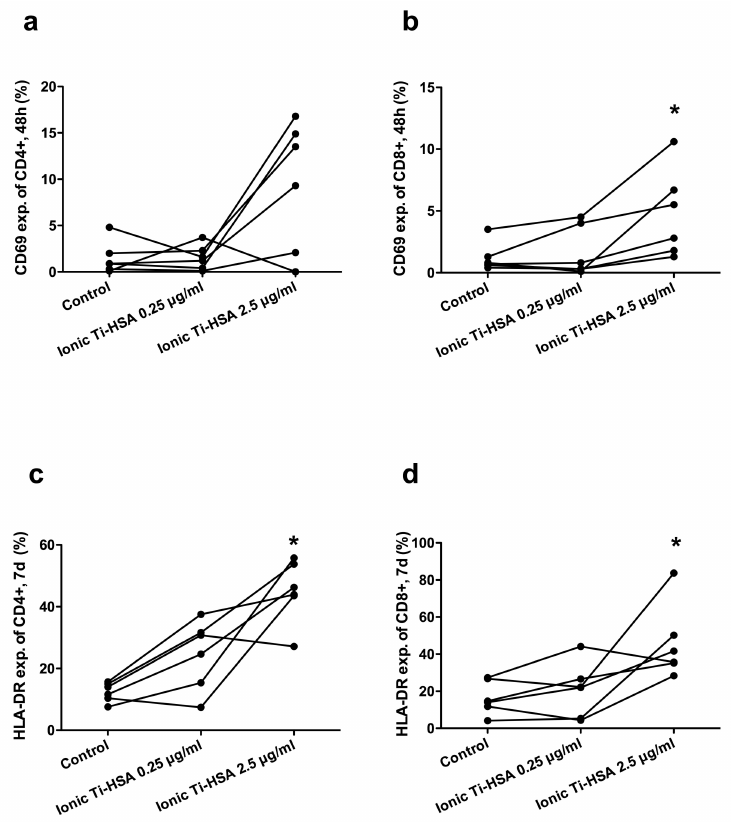
Figure 2. Expression of CD69 after 48 h ( a , b ) and HLA-DR after seven days ( c , d ) on CD4+ cells ( a , c ) and CD8+ cells ( b , d ) after stimulation with ionic-Ti ( N = 6). * Wilcoxon matched pair, p <